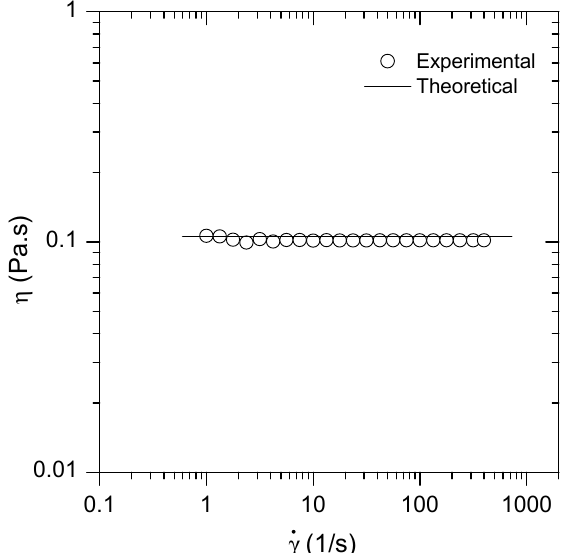
Figure A1. Viscosity versus shear rate of Cannon certified viscosity reference standard oil S60; open circles: measured viscosity; black line: expected viscosity (Cannon Instrument Company, State College, PA, USA) both at 25 °C.